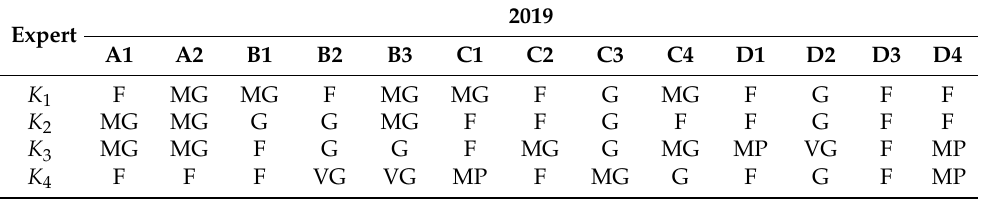
Table 12. Resilience rating scale of Shaanxi Province coal industrial chain and supply chain (2019). Expert